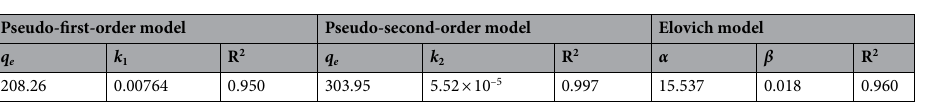
Pseudo-first-order model Pseudo-second-order model Elovich